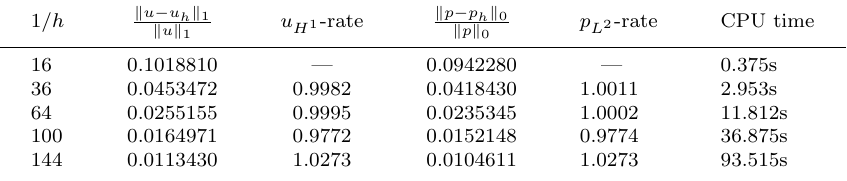
Table 2. Relative error and convergence rate of the one-grid method for the velocity and flux with τ 2 = h and ν = 1. 1 /h